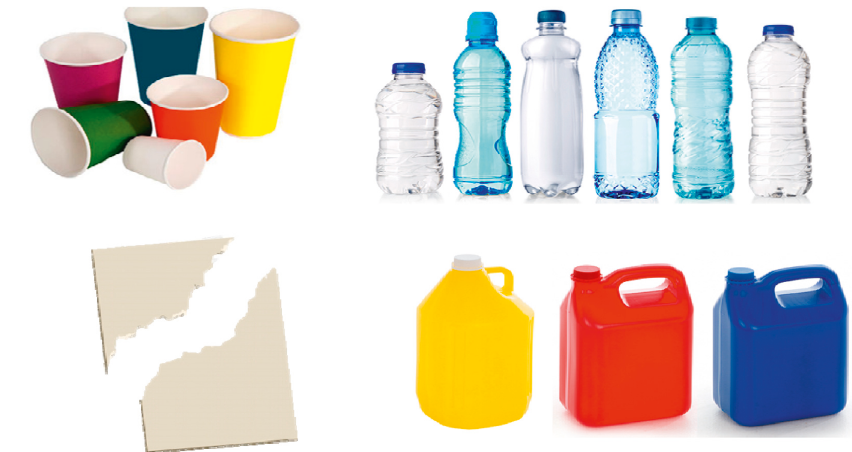
Figure 6: Suitable materials for crushing.